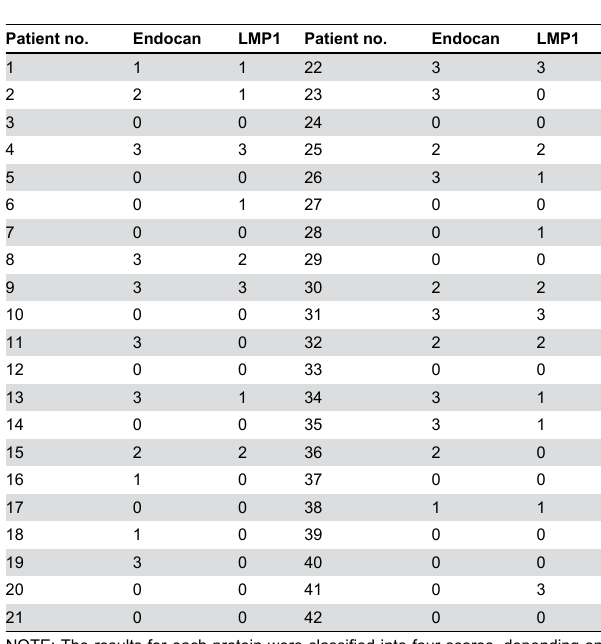
Table 1. Summary of immunohistochemical staining results for endocan and LMP1 in 42 NPC cases.